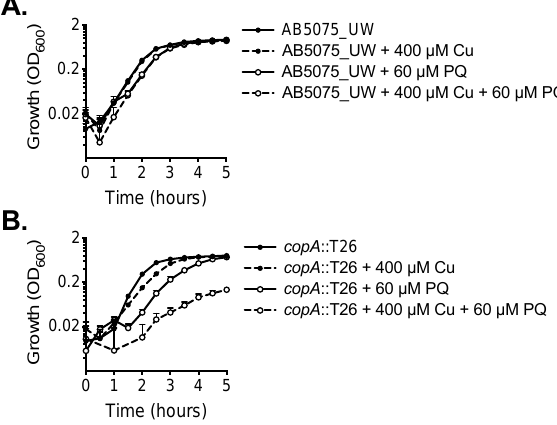
Figure 4. The effect of copper on oxidative stress tolerance. The growth of ( A ) wild-type AB5075_UW cells and ( B ) the copA ::T26 mutant was determined by measuring the optical density at 600 nm (OD 600 ) under untreated conditions or following supplementation of 400 µM CuSO 4 and/or 60 µM paraquat (PQ). The cultures were analysed at 37 °C with shaking (600 rpm), with measurements taken every 30 min. The data represent the mean (± SEM) of at least biological triplicates.